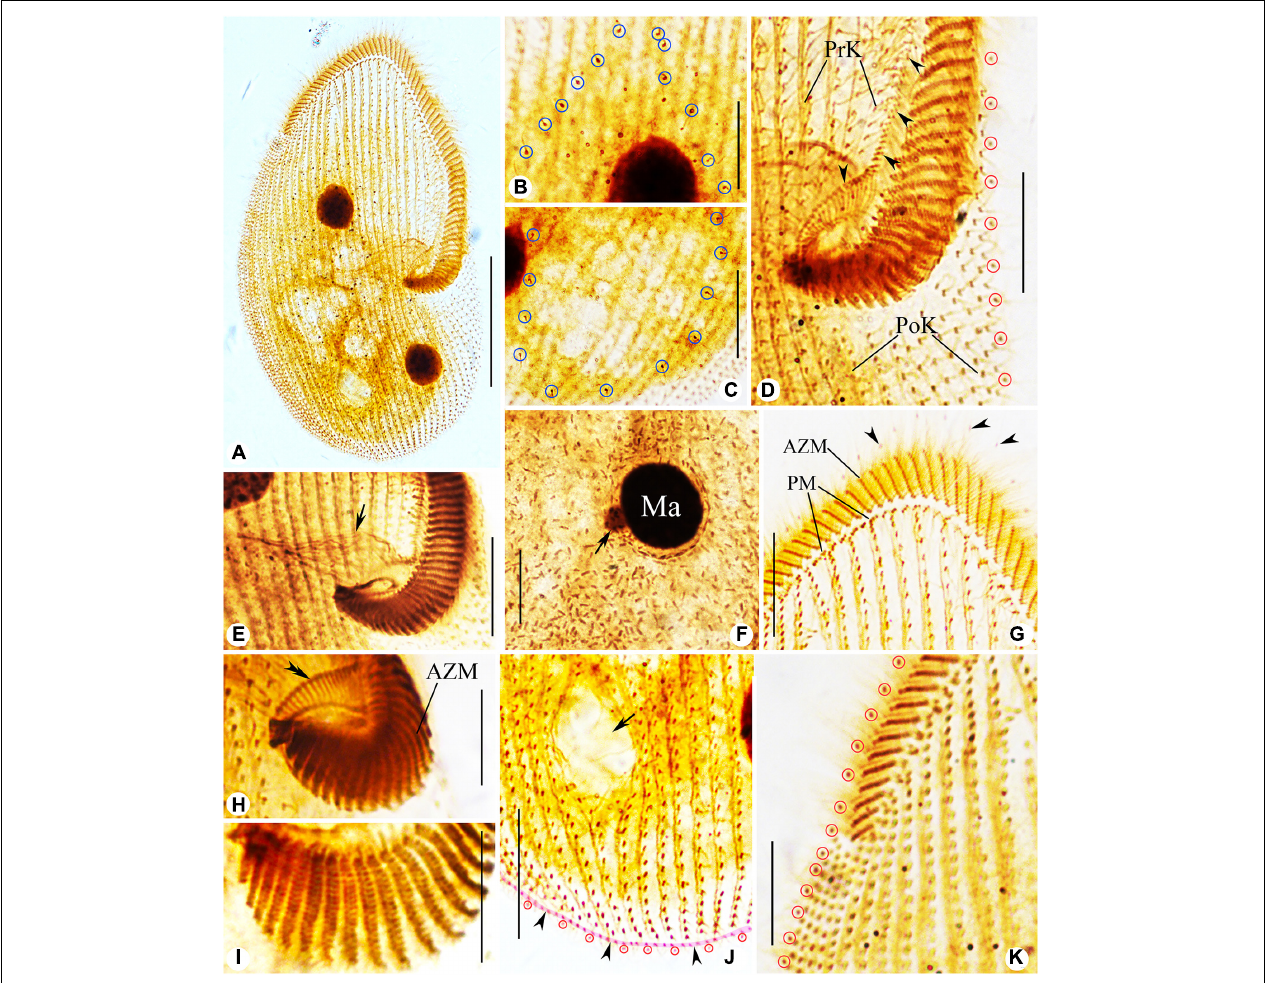
FIGURE 6 | Photomicrographs of Peritromus kahli (E , F , H , I) population-I and (A–D , G,J,K) population-II after protargol staining. (A) Ventral view of a typical individual. (B , C) Dorsal views, to show the internal dorsal kinetids (blue circles). (D , E , H , I) Detail of oral area; arrowheads indicate the paroral membrane, arrow indicates the cytostome, and double arrowhead marks the fiber bundles, and red circles mark the external dorsal kinetids. (F) To show a macronuclear nodule and its associated micronucleus (arrow). (G) Ventral view of anterior portion of cell; arrowheads mark the external dorsal kinetids. (J) Ventral view of posterior region of cell; arrow indicates a wide gap (possibly the cytoproct) between kineties; pink line (arrowheads) highlights the caudal margin kinety, and red circles mark the external dorsal kinetids. (K) Ventral view of right front, and red circles mark the external dorsal kinetids. Abbreviations: AZM, adoral zone of membranelles; PM, paroral membrane; PoK, postoral kineties; PrK, preoral kineties; Ma, macronucleus. Scale bars = 50 µ m (A) , 15 µ m (B–G , K) , 30 µ m (J) , and 10 µ m (H , I) .